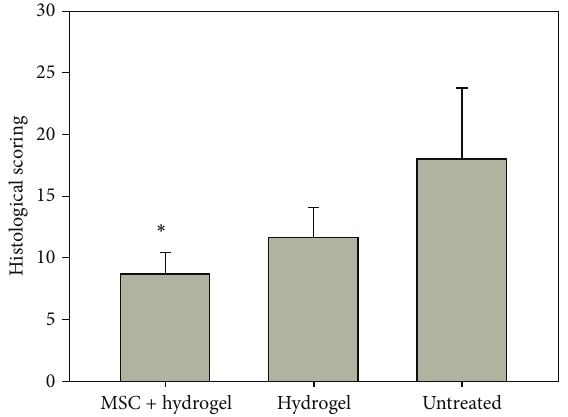
nucleus pulposus, using accurate fluoroscopy visualization.